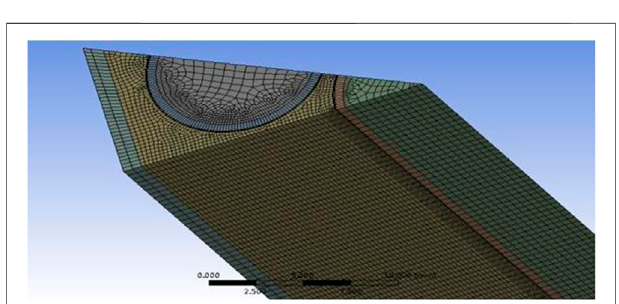
FIGURE 9 | Fission power distribution of FPPRU2.